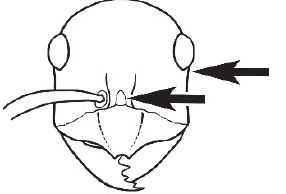
Frontal carinae of minor worker (major worker unknown) raised and laminate at edges; frontal triangle narrowly semi-oval; sides of head concave below eyes, giving it a bell-shaped appearance; in profile, pronotum and mesonotum form a gentle curve (as in Fig.) (Kimberley region, WA) ( JDM 948 ) (Fig. 14a–d) .............................................................................. griseus